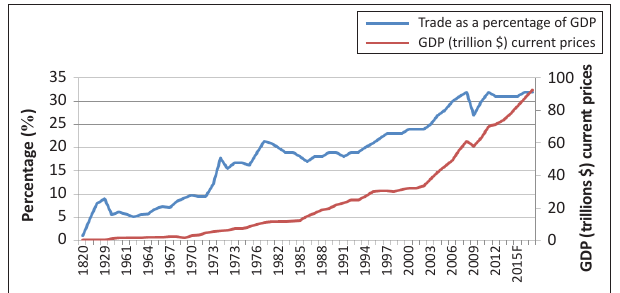
FIGURE 5: World trade as a percentage of world Gross Domestic